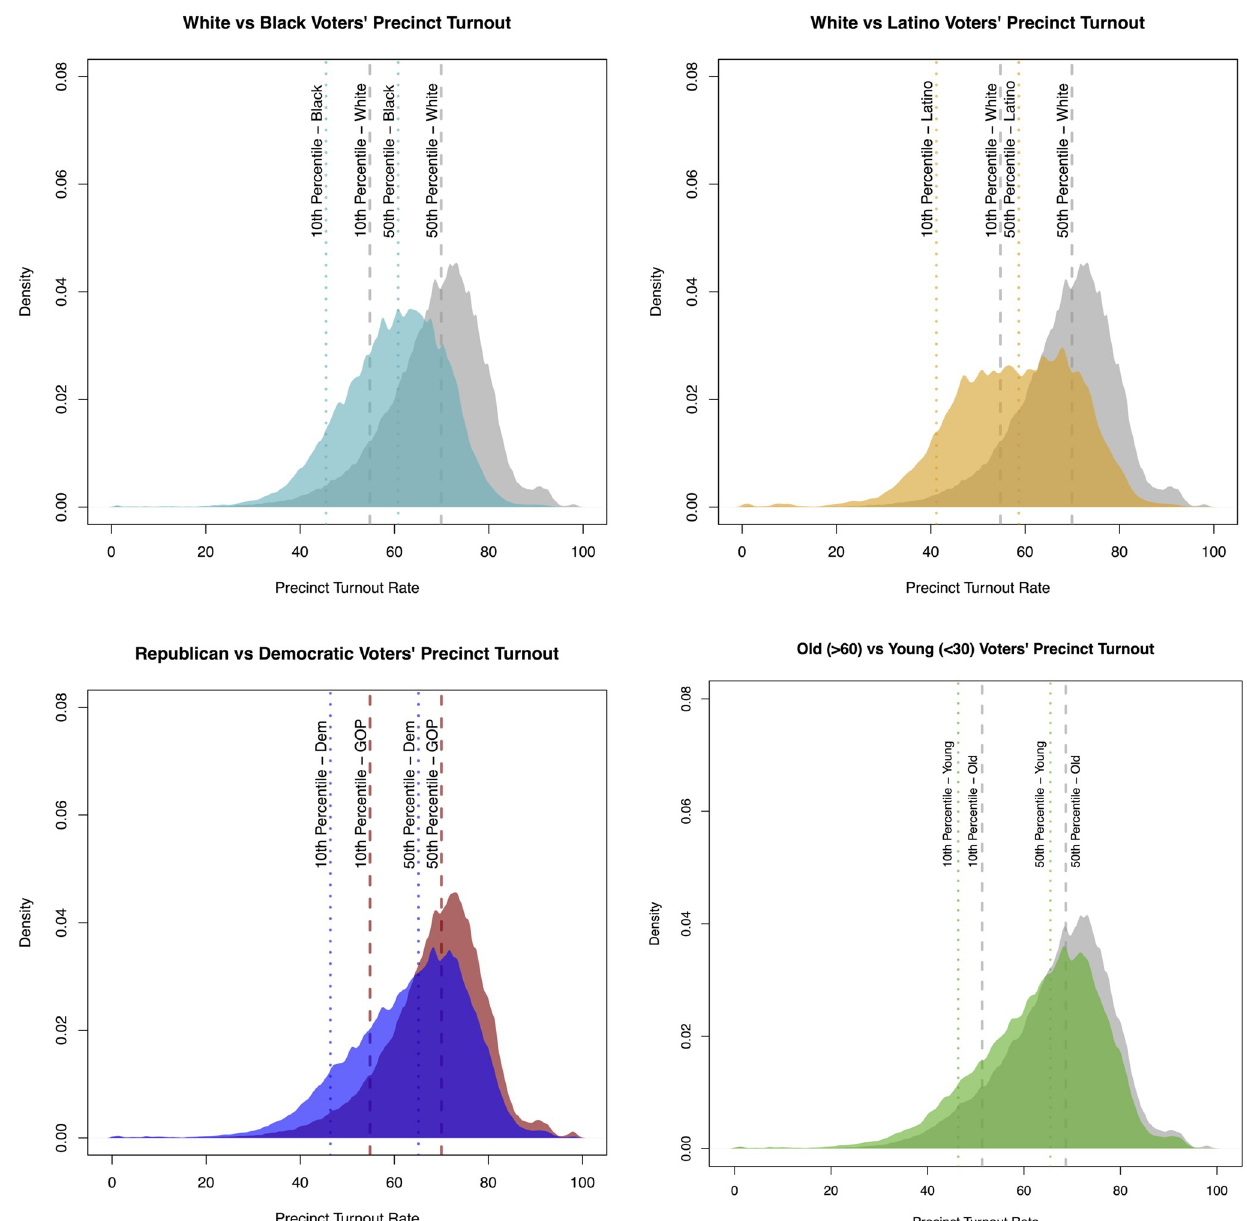
Fig 2. Distributions of validated voter turnout rates by groups distribution of electoral precinct turnout for individuals of various groups in 2016. The first two figures show that Black and Hispanic individuals are much more likely to live in a precinct where few people vote than White citizens (White distribution is colored grey in both figures). The same pattern holds for Democrats (blue distribution) compared to Republicans (red distribution) and to a slightly lesser extent young people (green distribution) compared to older people (grey